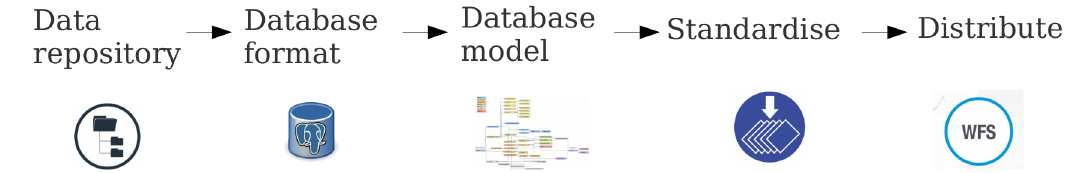
Figure 1. Schematic representation of the WoSIS workflow for safeguarding and processing disparate soils datasets.